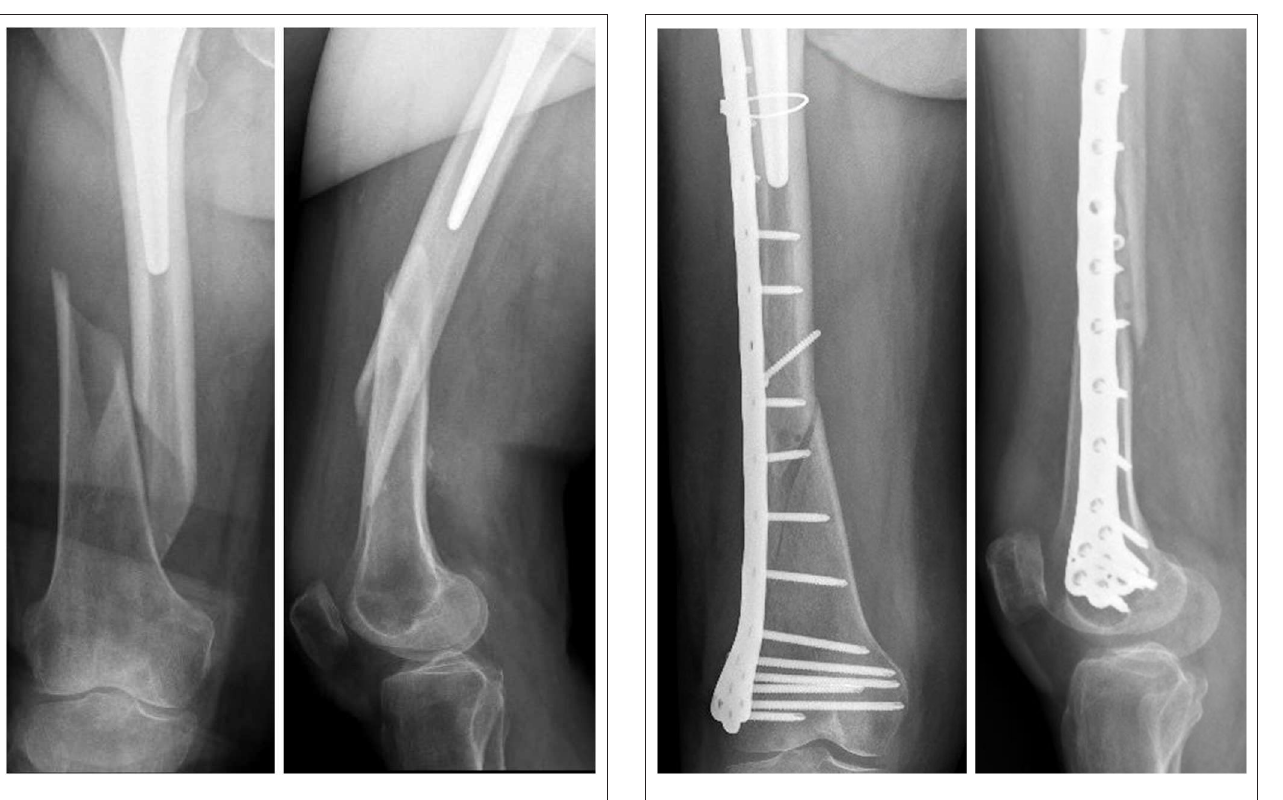
crossing the fracture rime, was inserted. Diameters and lengths